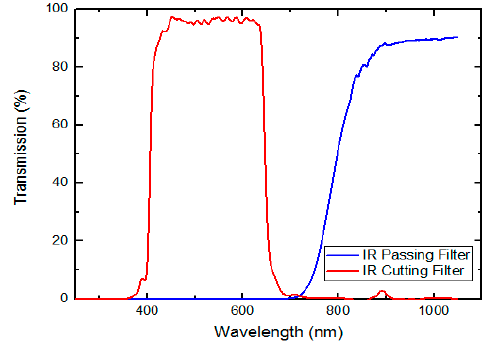
Figure 4. IR passing and IR cutting filter spectral responses of Basler acA2000-340kc camera.